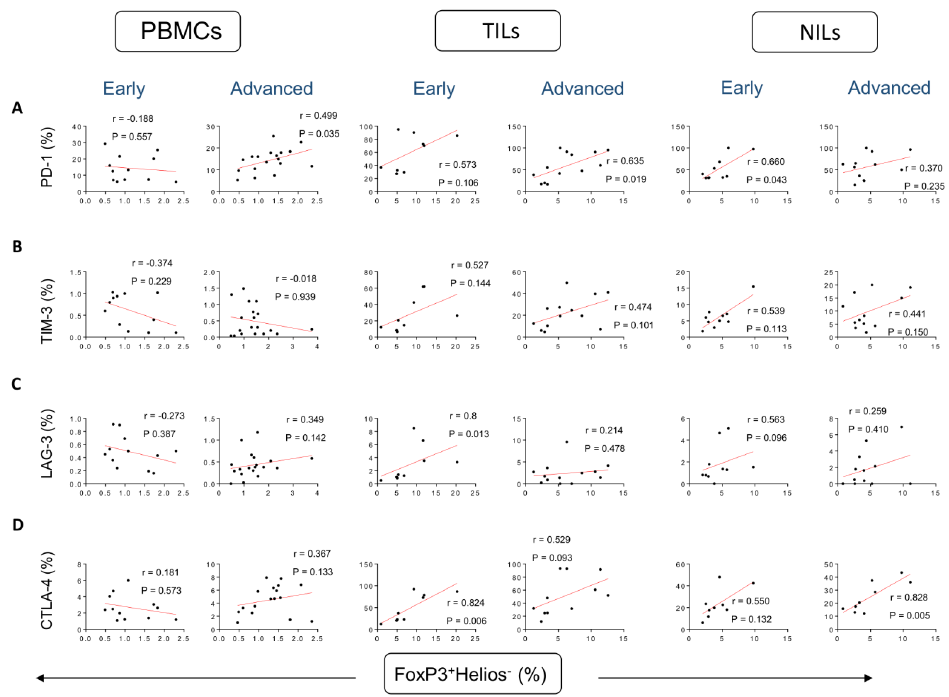
Vaccines 2022 , 10 , x FOR PEER REVIEW 7 of 12 Figure 3. Correlations between frequencies of FoxP3 + Helios − and immune checkpoints in CD4 + T cells in CRC patients based on disease stages. Correlations between frequencies of CD4 + FoxP3 + Helios − Tregs with PD-1 + ( A ), TIM-3 + ( B ), LAG-3 + ( C ), and CTLA-4 + ( D ) in PBMCs, TILs, and NILs in CRC patients with early and advanced stages. Conversely, negative correlations were found between frequencies of FoxP3 − Helios − T cells and CD4 + PD-1 + T cells in the TME in patients with early and advanced tumor stages (r = − 0.662, p = 0.052 [early]; r = − 0.576, p = 0.039 [advanced]) (Figure 4A), and in NILs the correlation was stronger in early tumor stages, compared to advanced stages (r = − 0.709, p = 0.026 [early]; r = − 0.430, p = 0.162 [advanced]) (Figure 4A). Moreover, strong negative correlations were found between frequencies of FoxP3-Helios- non-Tregs and CD4 + TIM- 3 + T cells in TILs, and they were found to be stronger in advanced tumor stages compared to early stages (r = − 0.751, p = 0.019 [early]; r = − 0.812, p = 0.0007 [advanced]) (Figure 4B). Furthermore, strong negative correlations were found between frequencies of FoxP3 − He- lios − T cells and CD4 + LAG-3 + T cells in TILs in patients with early tumor stages (r = − 0.833, p = 0.008 [early]; r = − 0.506, p = 0.079 [advanced]) (Figure 4C). The frequencies of FoxP3 − He- lios − T cells and CD4 + CTLA-4 + T cells in PBMCs were found to have stronger negative correlations in advanced tumor stages, compared to early stages (r = − 0.041, p = 0.903 [early]; r = − 0.651, p = 0.003 [advanced]). Conversely, such correlations were stronger in early stages, compared to advanced stages in the TME (r = − 0.892, p = 0.002 [early]; r = − 0.702, p = 0.018 [advanced]) (Figure 4D). The correlation in NILs was stronger in ad- vanced tumor stages, compared to early stages (r = − 0.316, p = 0.410 [early]; r = − 0.925, p =